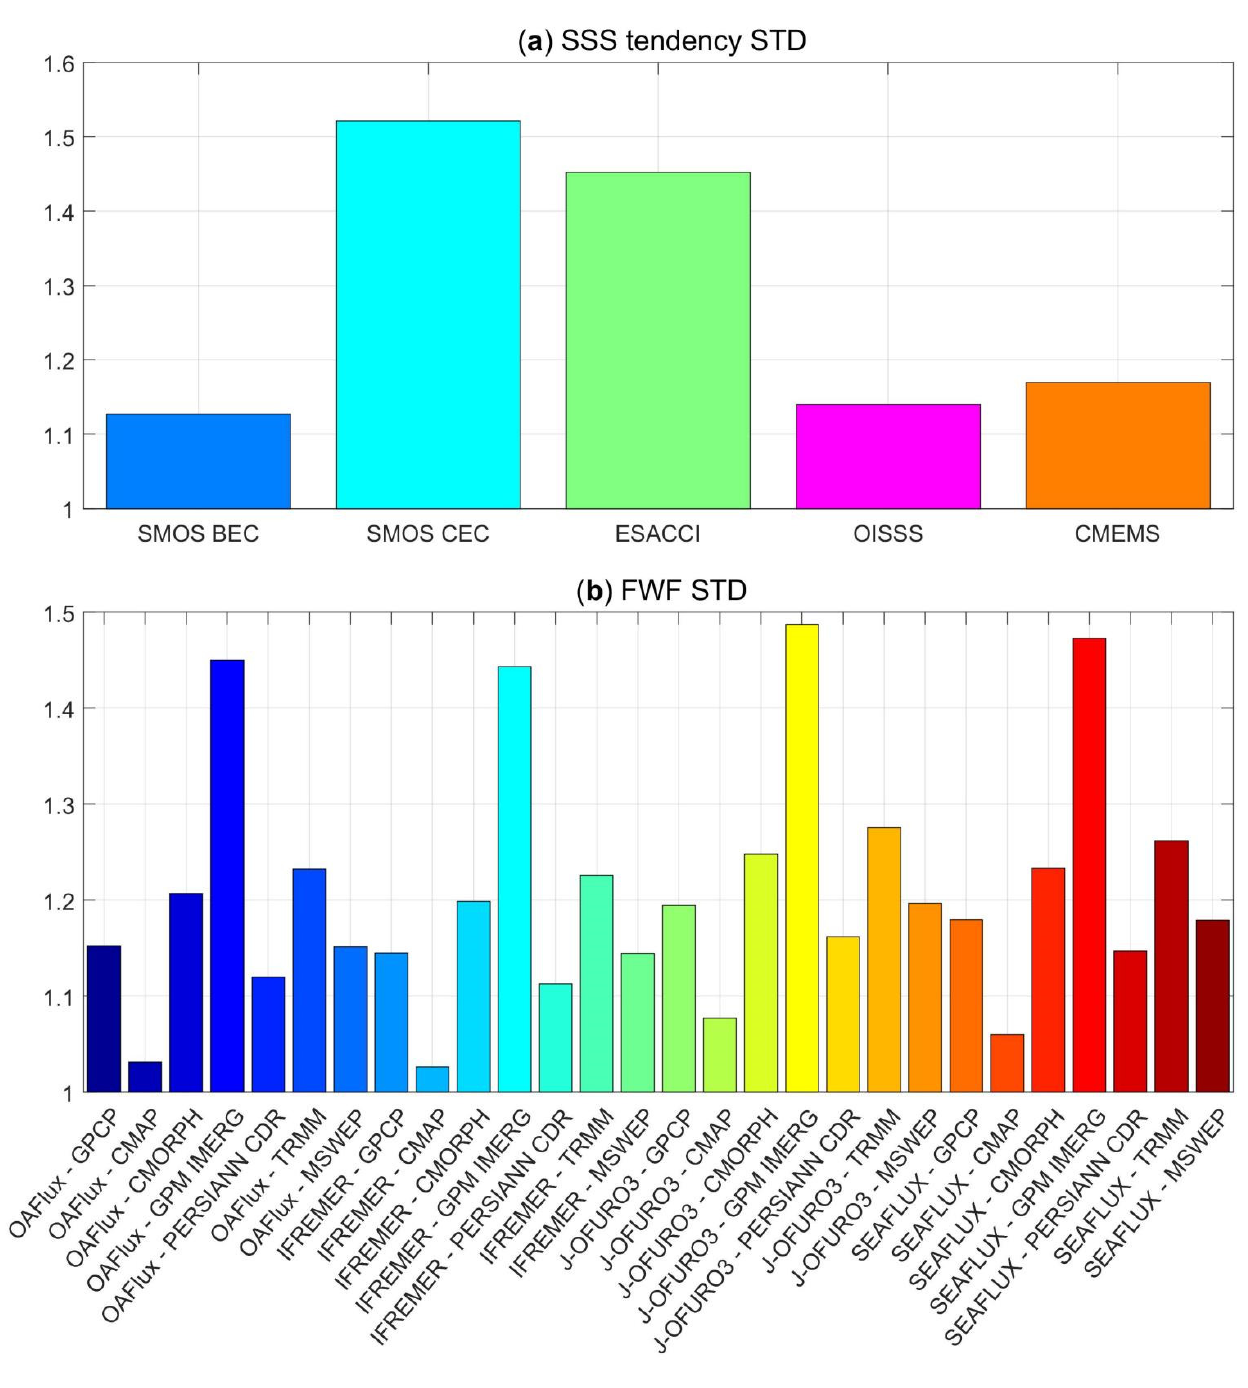
Figure 5. ( a ) The area-weighted variability of SSS tendency based on four sets of satellite-based products and ( b ) variability of FWF based on 28 sets of EMP from 2012 to 2017. In ( a ), the light blue bar denotes SMOS BEC; the cyan bar denotes SMOS CEC; the green bar denotes ESA CCI; the magenta bar denotes OISSS; and the orange bar denotes CMEMS. In ( b ), from dark blue to light blue bars indicate combinations between OAFlux and seven precipitation datasets; from cyan to bright green bars denote combinations between IFREMER and seven precipitation datasets; from light green to orange bars indicate combinations between J-OFURO3 and seven precipitation datasets; and from light red to dark red bars represent combinations between SEAFLUX and seven precipitation datasets. The units for variability are g/kg/year.